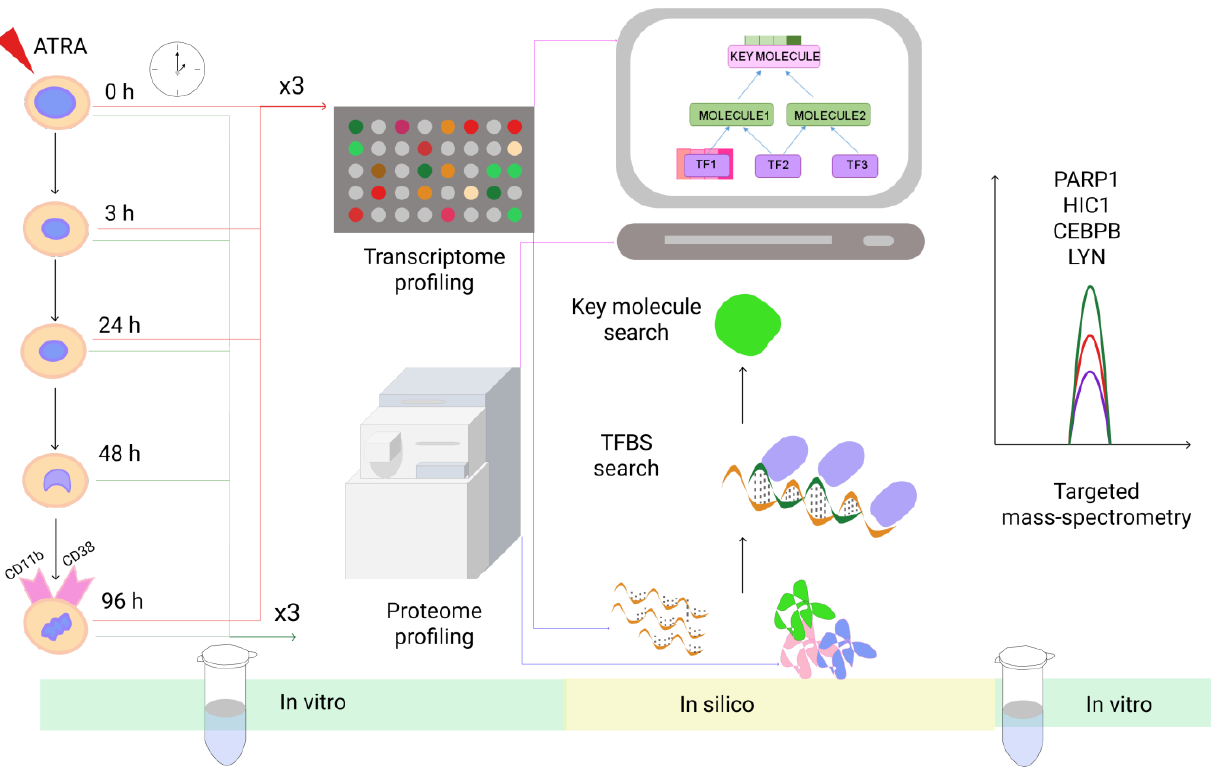
Figure 1. The study workflow. We applied a multi-disciplinary platform to study ATRA-induced granulocytic differentiation in a time-course manner using HL-60 cell line as a model. We combined LC-MS/MS analysis (0, 3, 24, 48, and 96 h after ATRA treatment, three bio repeats), whole-genome transcriptome analysis (0, 3, 24, and 96 h after ATRA treatment, three bio repeats), and bioinformatic search for transcription factor binding sites (TFBS) and for the key regulatory molecules. To verify the predicted regulatory networks the abundance of proteins HIC1, CEBPB, LYN, and PARP1, belonging to the designed model regulatory networks or involving in differentiation onset, were measured in time-course manner by selected reaction monitoring (SRM) using synthetic isotopically-labeled peptides as